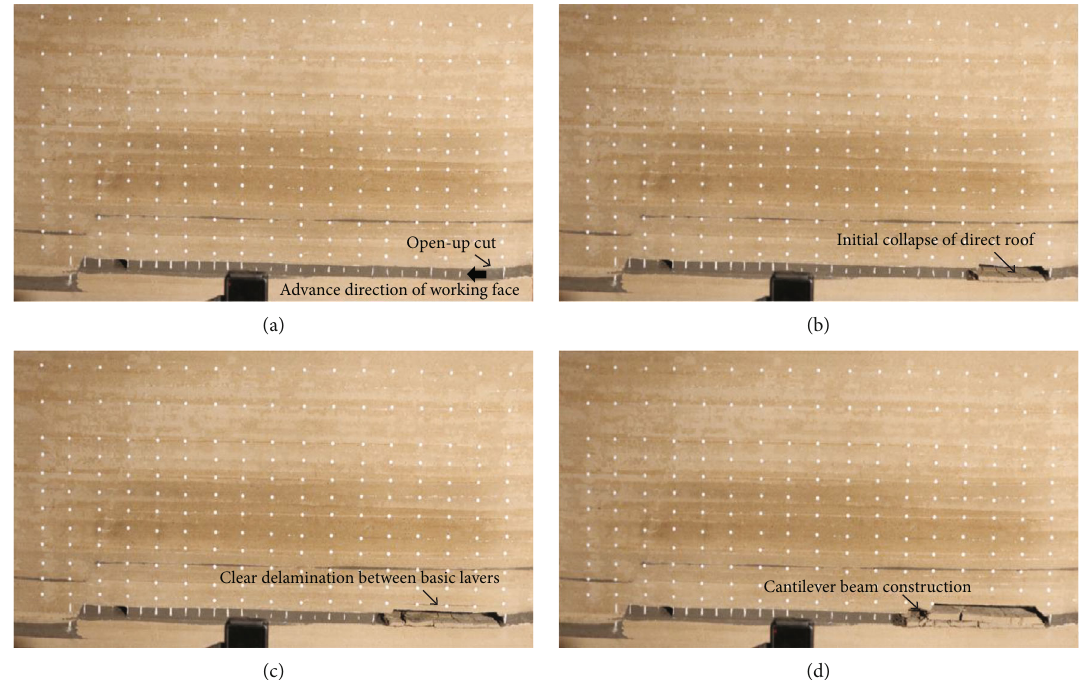
Figure 8: Immediate roof collapse diagram when the working face is advanced at di ff erent distances: (a) 0 m, (b) 40m, (c) 78 m, (d) 80